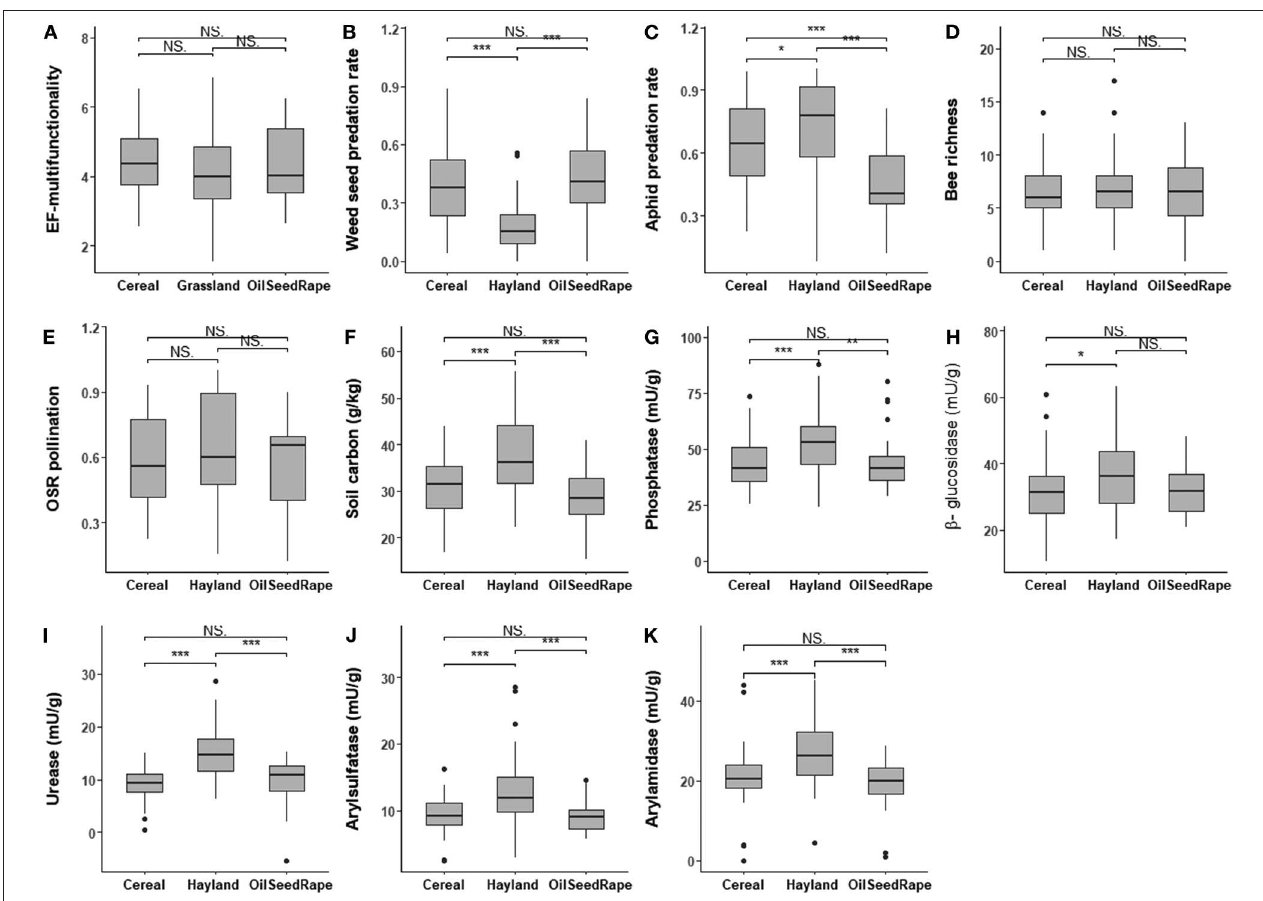
FIGURE 2 | Among crop type variation of EF-multifunctionality (A) and each ecological function (B–K) . Soil enzyme activities are expressed in mU.g − 1 dry soil, representing nanomoles of product released per minute and per g of equivalent dry soil. Significant differences are indicated by *( P < 0.05), **( P < 0.01), and ***( P < 0.001). NS indicates a non-significant